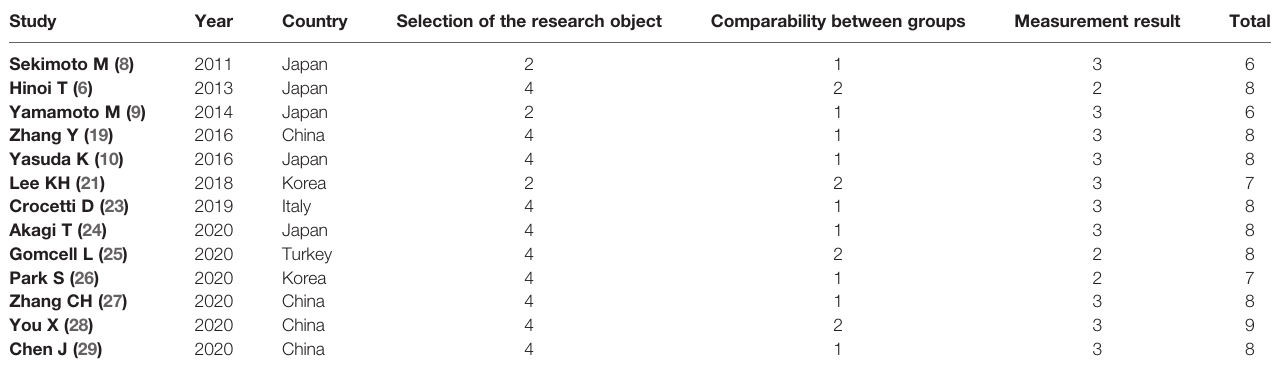
TABLE 3 | Quality of non-randomized studies as assessed by the Newcastle – Ottawa Scale. Study Year Country Selection of the research object Comparability between groups Measurement result